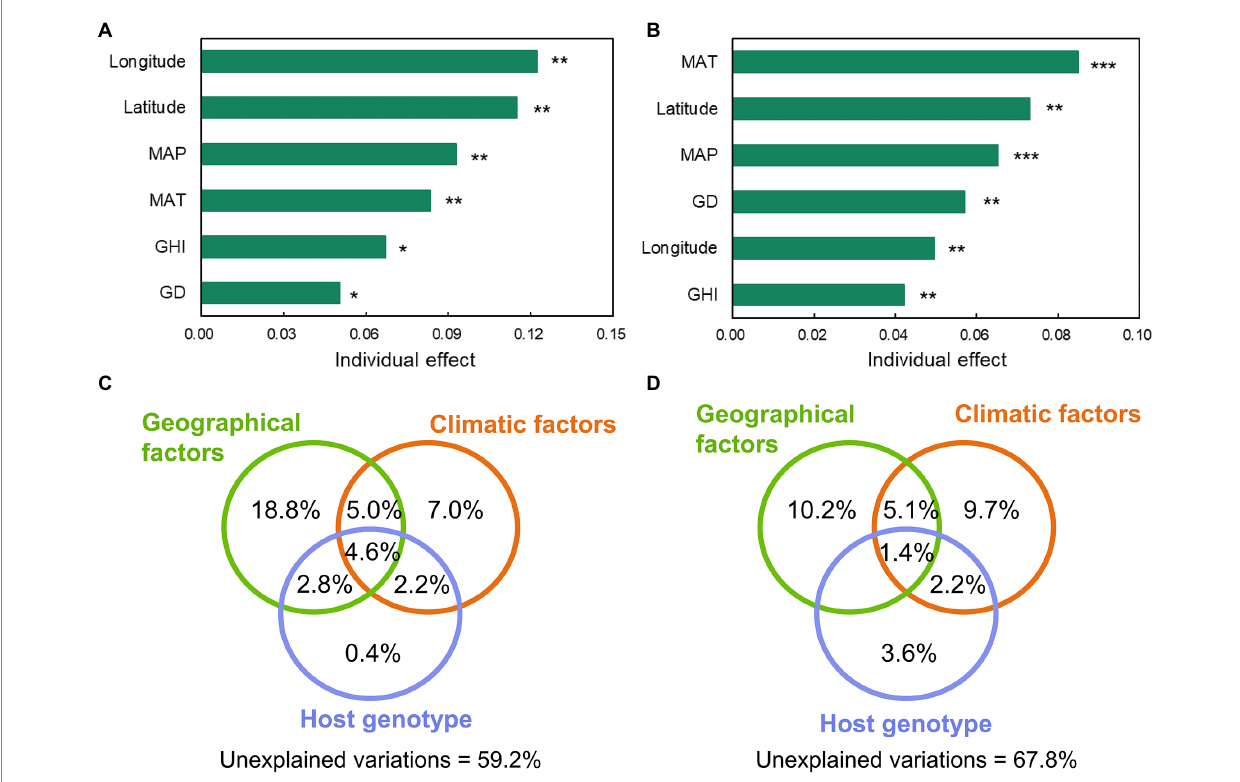
FIGURE 4 The individual effect of the environmental and host genetic distance variables to explain the variation of bacterial (A) and fungal (B) communities at genus level in the foliar microbiome of wild soybean (“*,” 0.01 < p < 0.05, “**,” 0.01 < p < 0.001, “***,” p < 0.001). The relative importance of individual variables was calculated using rdacca.hp package. GD, genetic distance; MAP, mean annual precipitation; MAT, mean annual temperature; and GHI, global horizontal irradiance. The effects of explanatory variables (geographical, climatic, and host genotype) on bacterial (C) and fungal (D) communities were estimated using variation partition analysis. Shared effects are indicated by the overlap of circles. Geographical factors include longitude and latitude. Climatic factors include MAP, MAT, and GHI. The host genotype represents the host genetic